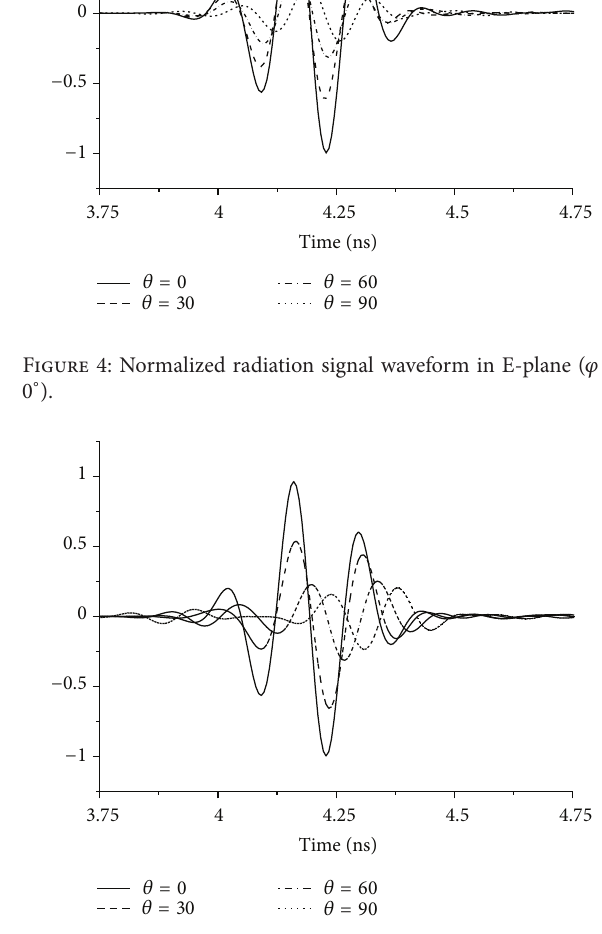
Figure 3: Excitation signal.